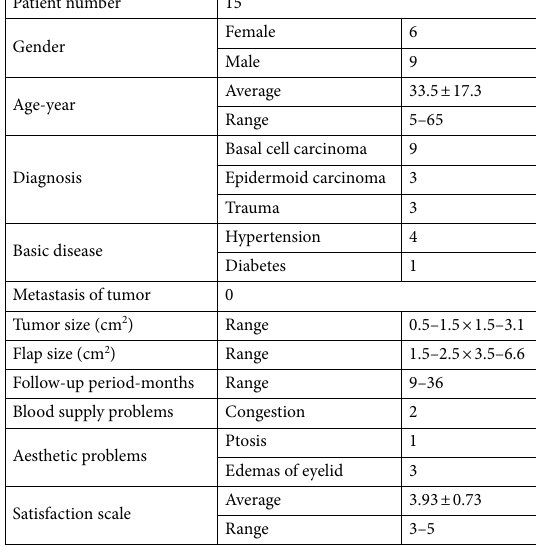
Table 1. The characteristics of patients enrolled in this